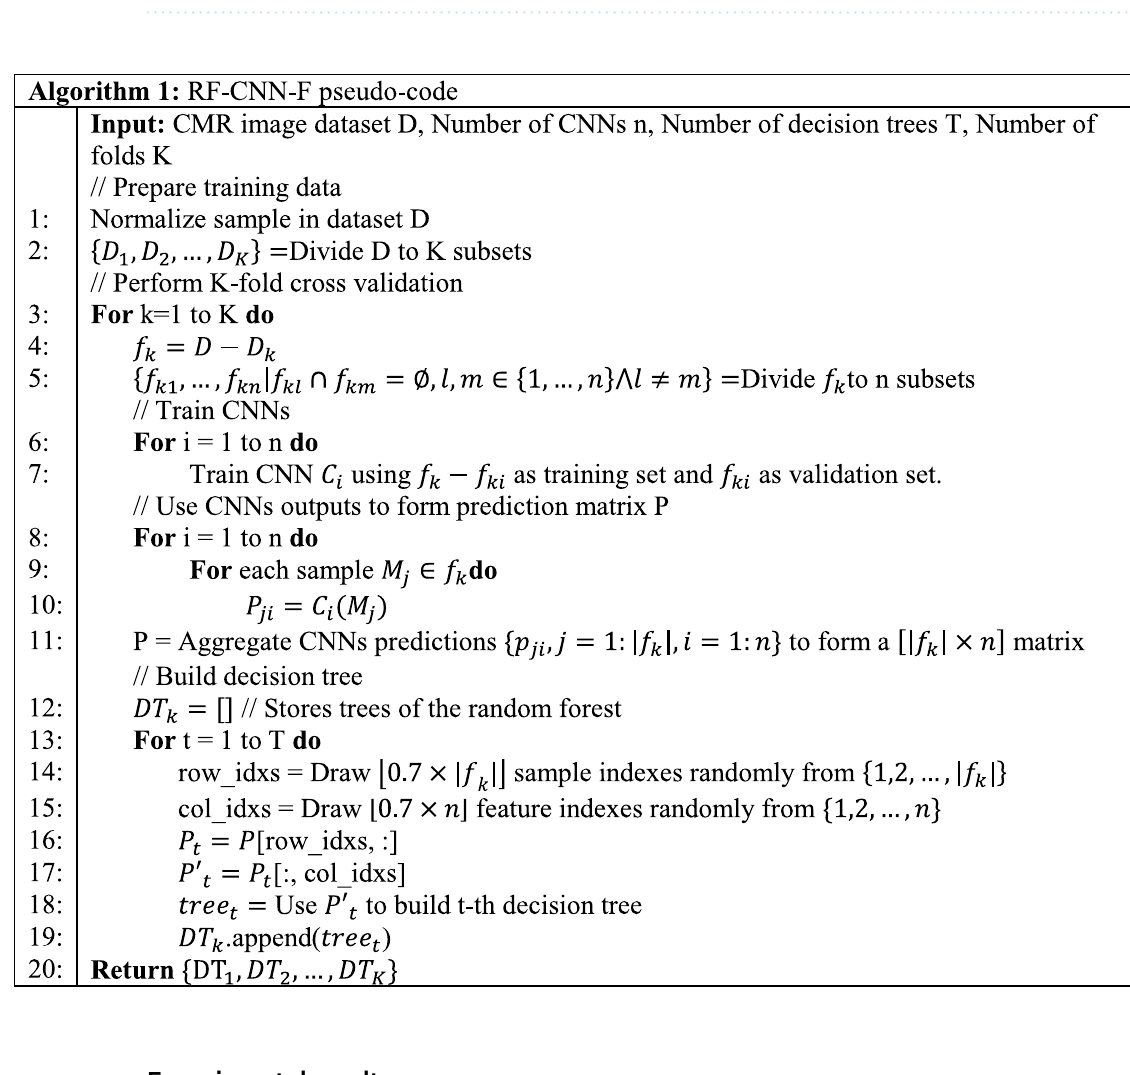
Figure 7. The graphical representation of operations in lines 8–19 of Algorithm